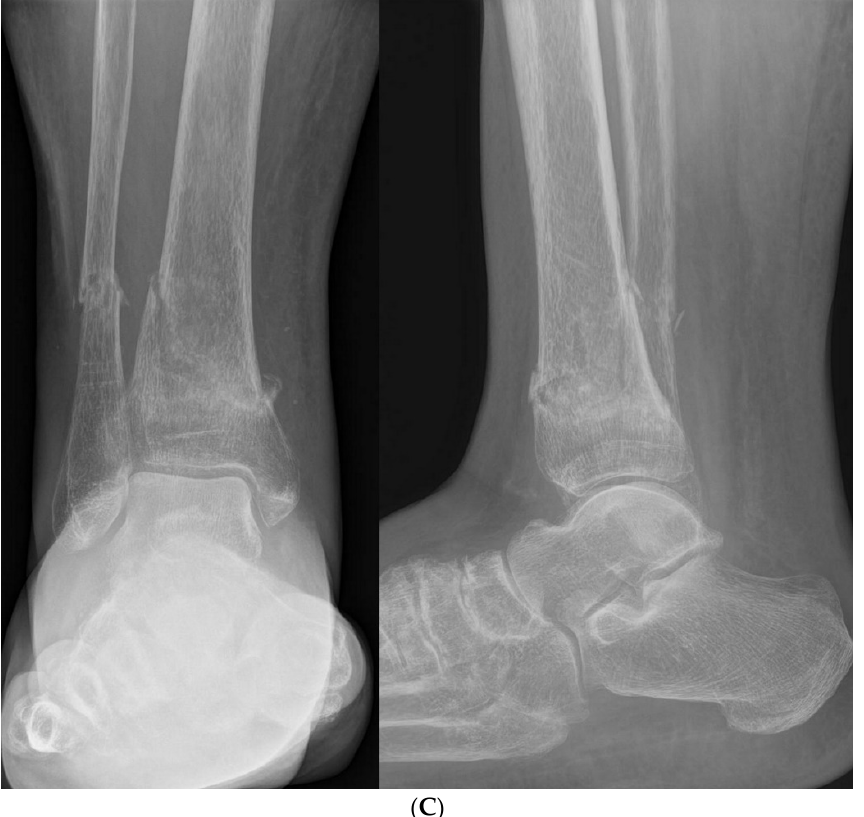
Figure 6. ( A ) Examples of pathological findings in adults (in comparison with the normal conditions in children from Figure 5). ( a ) Suprapatellar recess of a 48-year-old male with moderately severe inflammation due to gout. Visible folds of thickened synovium and a moderately increased amount of fluid. Linear probe 6–12 MHz. ( b ) Power Doppler image showing an uneven cortical layer of the femur in a 75-year-old male with multiple metastases of prostate cancer in the bones (the patient did not know about his disease until the day of ultrasound examination of the limbs). Visible increased vascularization of the periosteum. Linear probe 3–12 MHz. ( c ) Damage to the subscapularis tendon in a 58-year-old male; the distance to which the tendon has contracted is marked with a dotted line, the hypoechoic areas in the lesion zone correspond to traces of fluid and folds of the thickened synovial membrane inverting into the area of the lesion. 3–12 MHz linear probe. ( d ) Stress fracture of the tibia in a 61-year-old woman: visible discontinuity of the cortical layer, thickening of the periosteum, and callus formation. Linear probe 3–12 MHz. (B) X-ray images of the right (on the left) and left (on the right) femurs of a patient whose US images are presented in Figure 6.1b. Visible osteolytic and osteosclerotic metastatic lesions in both femurs. ( C ) Anteroposterior and lateral X-ray images of the patient described in Figure 6.Ad. Patient presented with exacerbating pain in the distal 1/3 of the lower leg. There was no history of trauma.